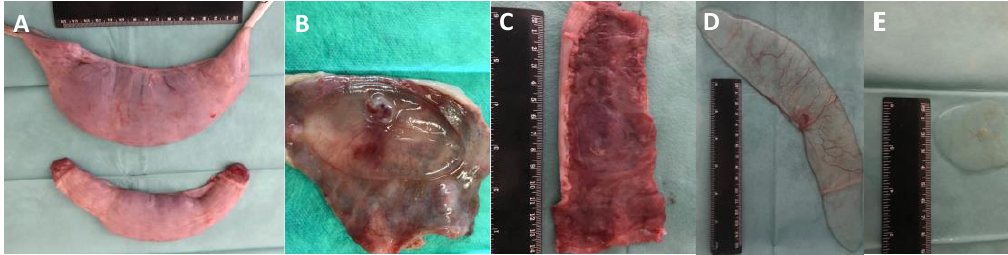
Figure 2. Representative images of two recipient uterine horns ( A ; normal and small chorionic sacs); and healthy ( B , D ) and arrested ( C , E ) pig conceptuses collected at D24 of pregnancy.